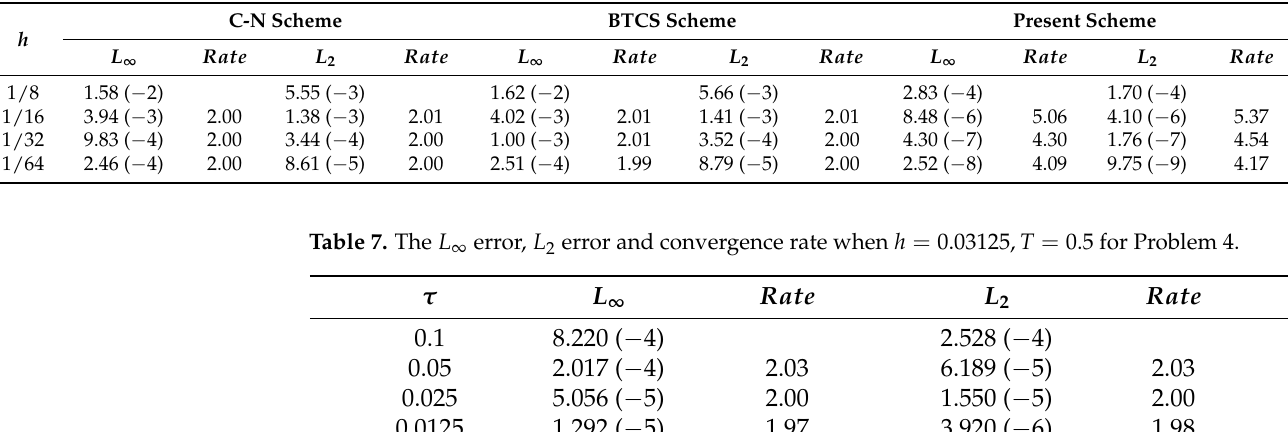
Table 6. The L ∞ error, L 2 error and convergence rate when τ = h 2 , T = 0.25 for Problem 4.